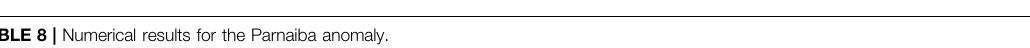
TABLE 8 | Numerical results for the Parnaiba anomaly. Model parameters